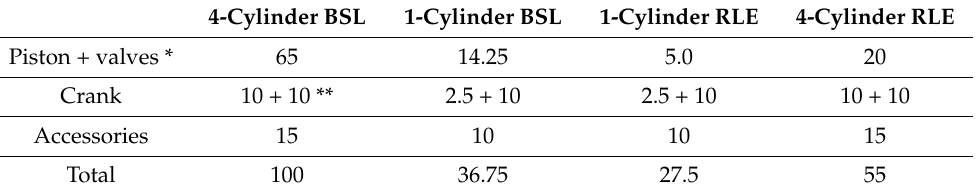
Table 3. Hypothetical accounting of friction energy percentages at 750 rpm idle relative to the 4- cylinder BSL. The numbers for the 4-cyl. BSL are adjusted to reasonable numbers from the literature. The numbers for the 1-cyl. BSL are adjusted based on the components removed. The 1-cyl. RLE piston is reduced until the measured margin in friction is reached. Then, the RLE 4-cyl. contains the friction of the added components over the 1-cyl. RLE. This scenario shows a 45% reduction in 4-cylinder idle fuel